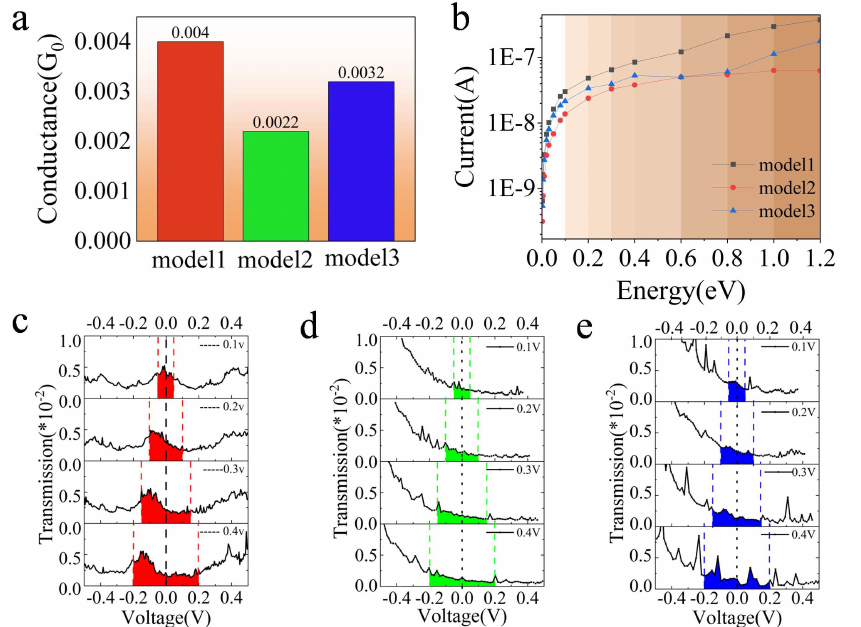
Figure A2. Comparison of electrical properties of defect-free models, ( a ) zero-bias conductance comparison of defect-free models of different materials; ( b ) I – V curves of three defect-free models; ( c – e ) transmission spectrum curves of model 1, model 2, and model 3. The region with different colors represents the contrast of transmission spectrum under different